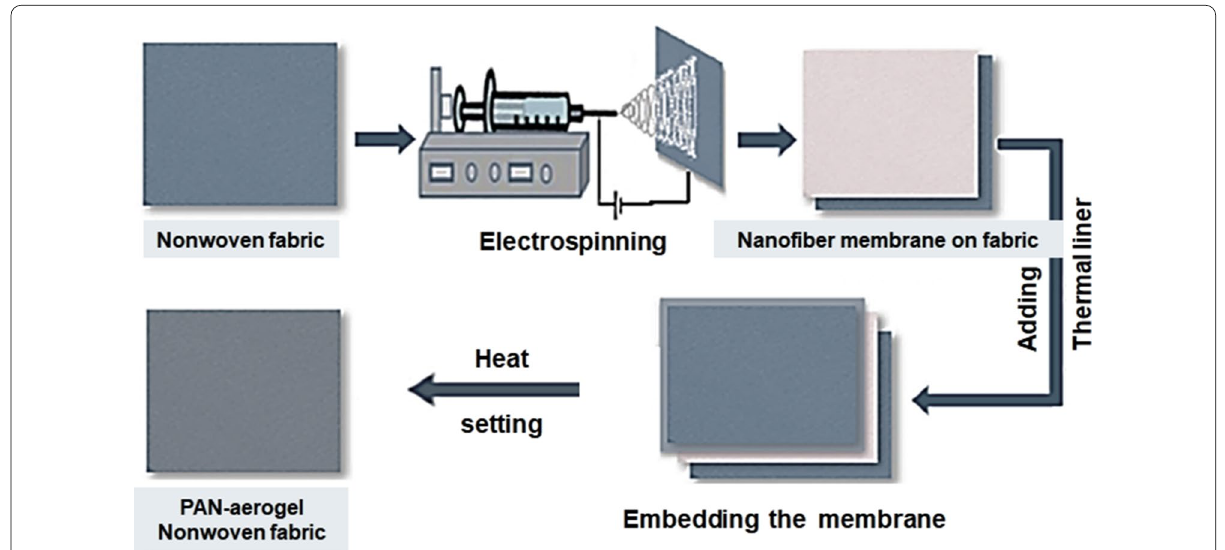
Fig. 11 Schematics of producing nonwoven-PAN and nonwoven-PAN-silica aerogel fabrics [22] Copyright 2020